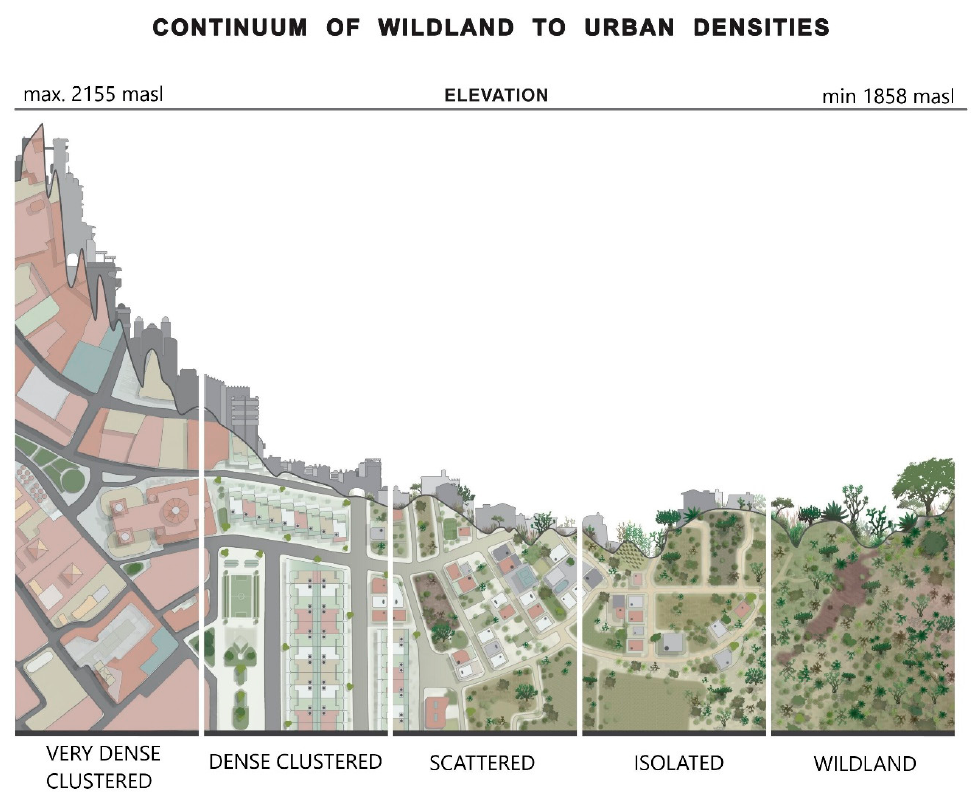
Figure 3. Topographic profile of the WUI in the MACG including the housing spatial categories. The gradient of elevation above sea level ranges from 1858 m to 2155